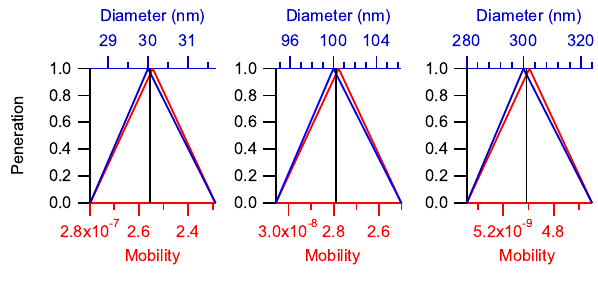
Fig. 9. Ideal mobility and diameter transfer functions for 30, 100 & 300nm particles. The vertical lines illustrate the difference between the selected mobility diameter and the mobility diameter at 50% of the area of the transfer